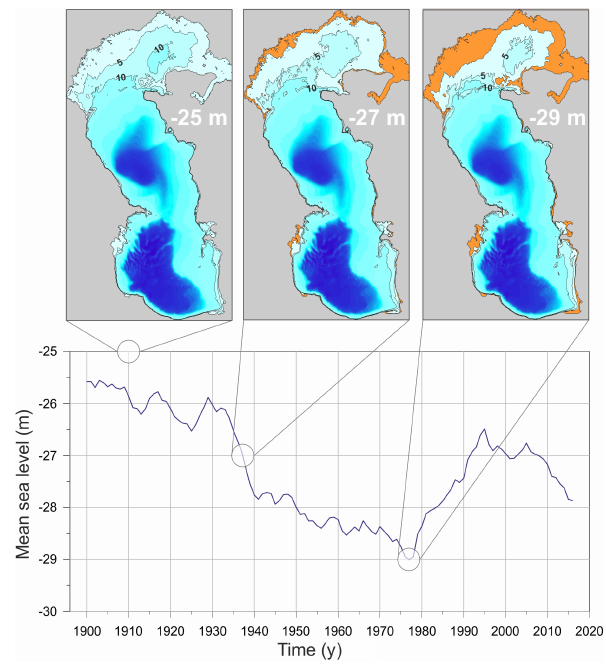
Figure 7. Changes in the mean sea level (MSL) of the Caspian Sea at Makhachkala and the bathymetry of the sea for MSL values of − 25, − 27, and − 29m with respect to the BHS. Numbers on the contours indicate the depths of the shallowest areas below MSL in each case. Orange areas became dry as a result of the assumed MSL changes below − 25m.